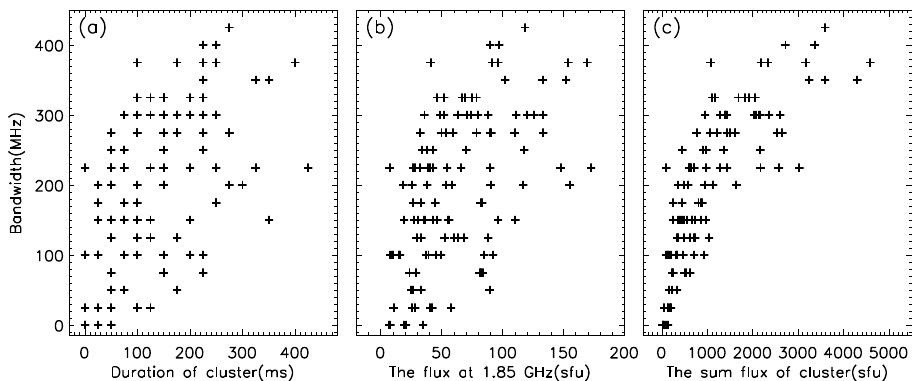
Figure 7. ( a ) The plot of the duration and the bandwidth of the clusters in sample III. ( b ) The plot of the sum of the flux at 1.85 GHz of QPPs and the bandwidth of the clusters in sample III. ( c ) The plot of the sum of the flux of spikes and the bandwidth of the clusters in sample